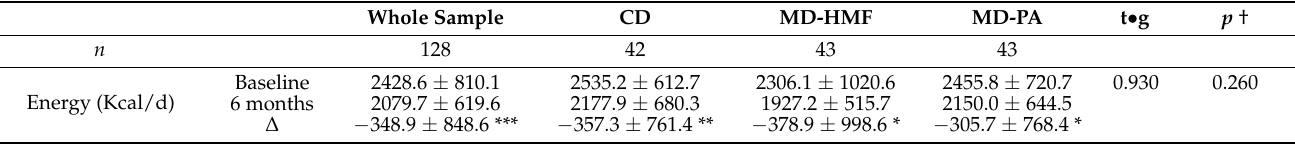
Table 4. Changes in energy and macronutrient intakes within and between intervention groups at 6 months versus